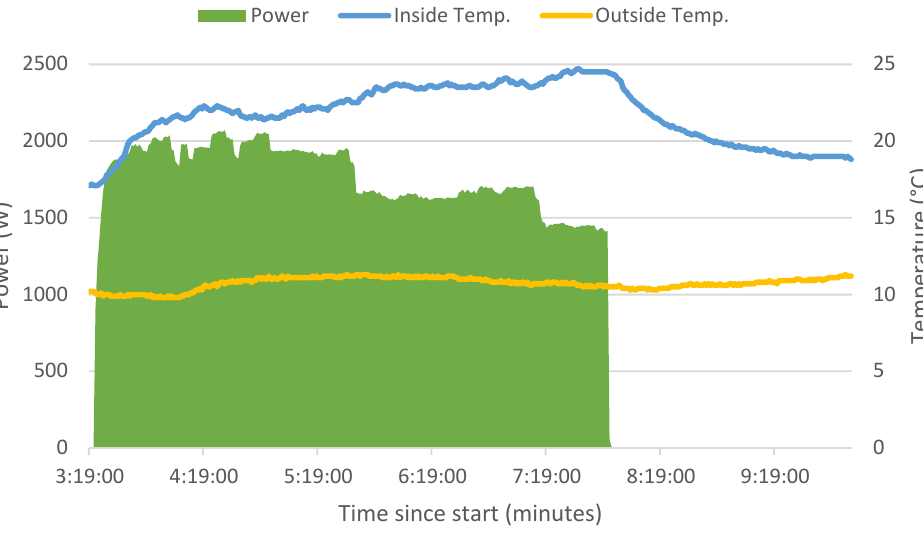
Figure 9. Test C: Power consumption, inside and outside temperature evolution over time.